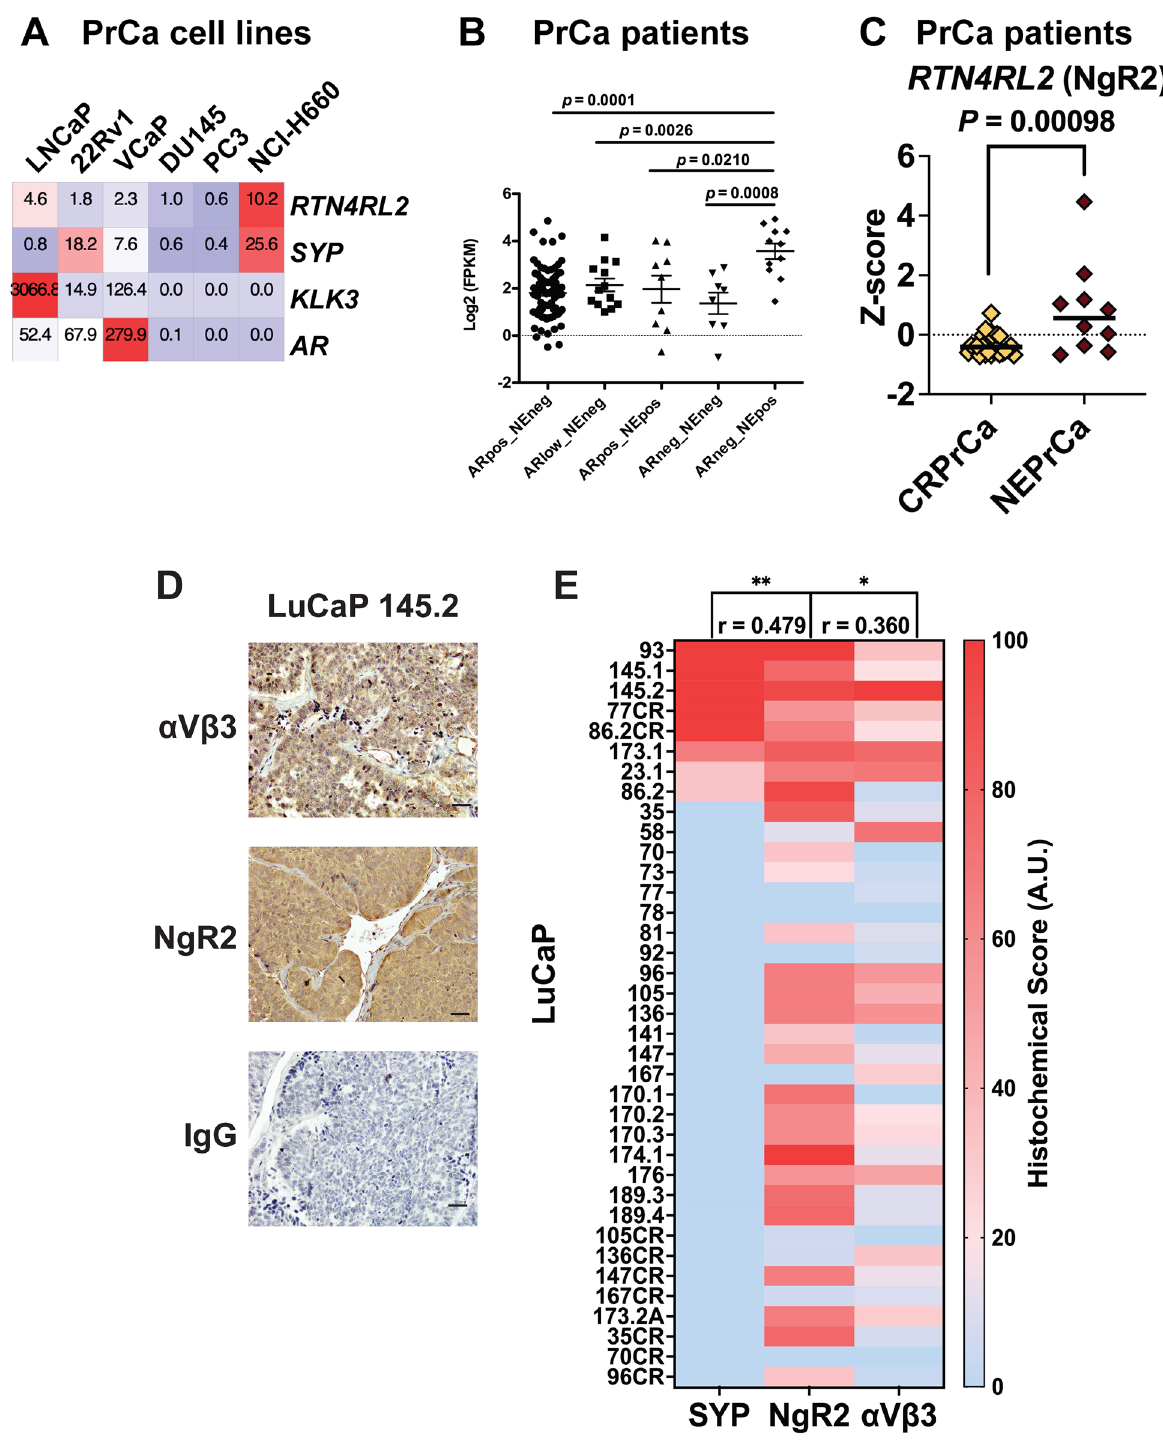
Figure 2. NgR2 expression is increased in NEPrCa patients, NE cell lines, and NEPrCa PDXs. ( A ) Left panel, mRNA levels for RTN4RL2 , SYP (Synaptophysin), KLK3 (Kallikrein Related Peptidase 3), and AR (Androgen Receptor) reported as Transcripts Per Million were compared across multiple PrCa cell lines in the CCLE database 50 . ( B ) RNA sequencing analysis for RTN4RL2 of metastatic CRPrCa specimens acquired through rapid autopsy of 98 patients. Specimens are classified based on their levels of AR and NE markers. AR-positive NE-negative (ARpos_NEneg, n = 76), AR low NE-negative (ARlow_NEneg, n = 13), AR-positive NE-positive (ARpos_Nepos, n = 9), AR-negative NE-negative (ARneg-NEneg, n = 8), and AR-negative NE-positive (ARneg_NEprs, n = 11). Statistical analysis was performed using GraphPad Prism (CA, USA) and differences between two groups were compared using unpaired student’s t-test. ( C ) RNA sequencing analysis of RTN4RL2 expression for CRPrCa and NEPrCa tumors from cBioPortal (dataset Neuroendocrine Prostate Cancer, Multi-Institute 20 ). Differential expression between the two groups is estimated by student’s t-test. ( D ) Representative IHC staining for the αVβ3 integrin or NgR2 of LuCaP PDX TMAs (n =37) is shown. IgG was used as negative control. The bar at the bottom right corner of each panel represents 20 μm. ( E ) Heat map of the histochemical score for SYP, NgR2, and the αVβ3 integrin of each LuCaP is shown. * P = 0.029; ** P = 0.003. Spearman correlation was performed and r-values are reported. The histochemical score for the αVβ3 integrin and SYP has been previously reported 13